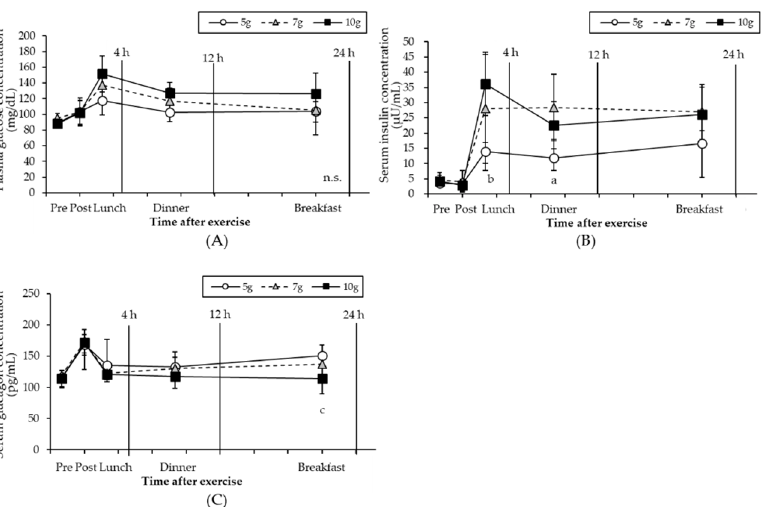
Figure 4. Changes in plasma glucose ( A ), serum insulin, ( B ), and plasma glucagon levels ( C ) Values are expressed as mean ± standard deviation. a: 5 g vs. 7 g groups, p < 0.05; b: 5 g vs. 10 g groups; p < 0.05; c: 7 g vs. 10 g groups, p < 0.05, n.s.: not significant.